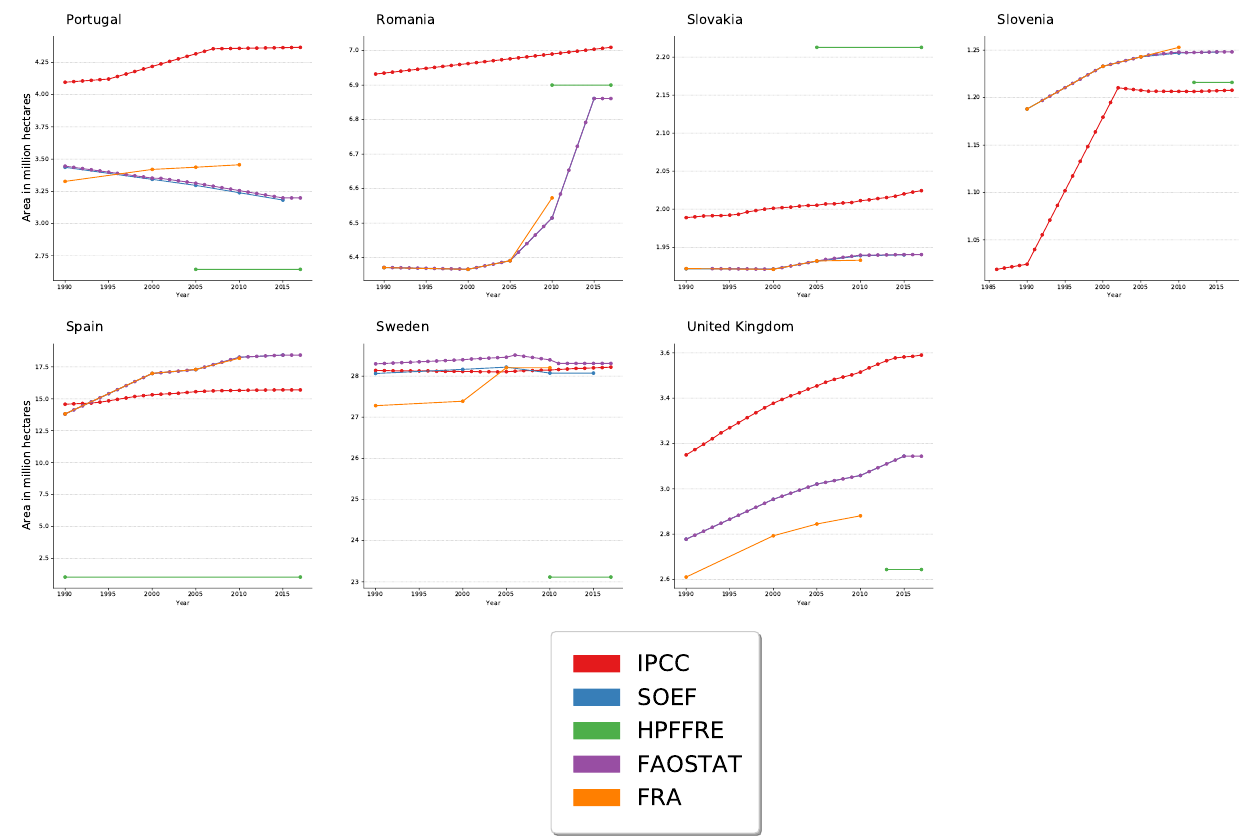
Figure 2. Total forest area in million hectares in the five data sources and 27 countries present in the